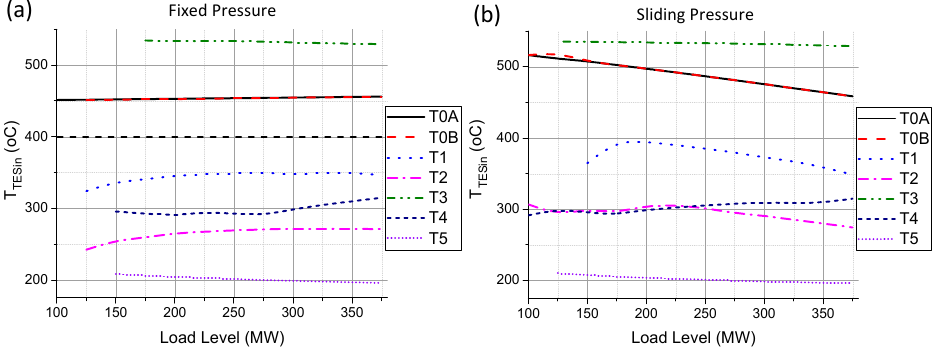
Figure 13. TES inlet temperature in FP ( a ) and SP ( b ) operating mode.